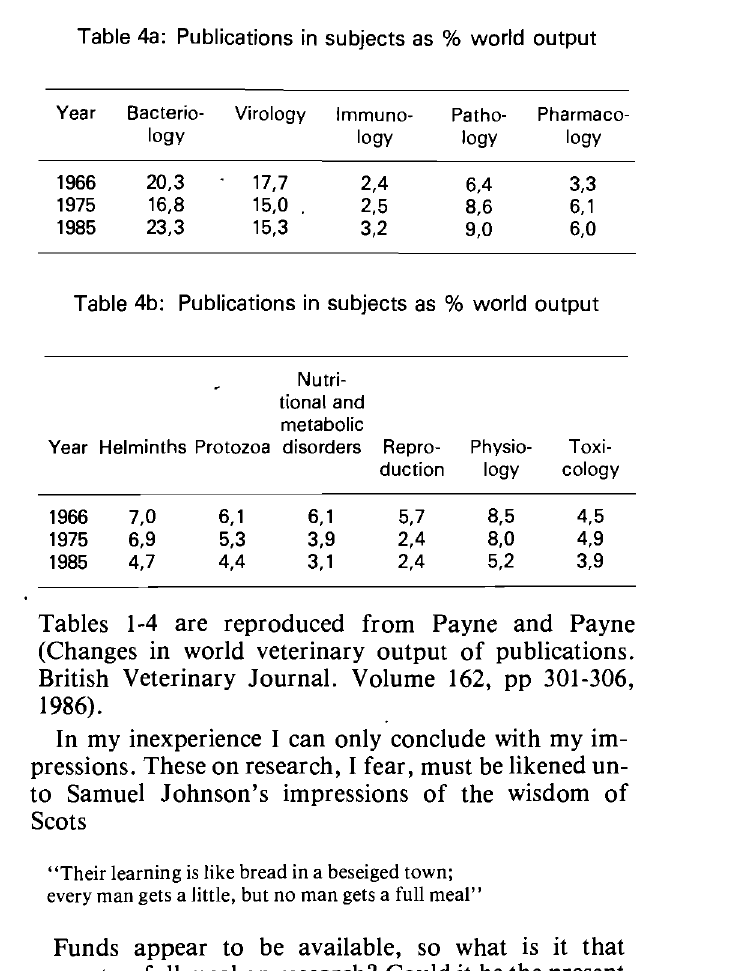
Table 1: USA and the EEC as % world output